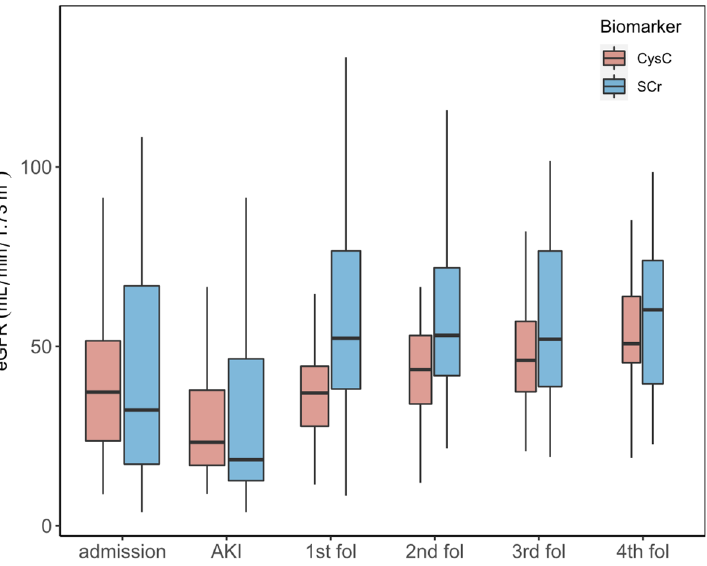
Figure 3. Comparison of estimated glomerular filtration rate using serum creatinine (eGFR SCr ) and estimated glomerular filtration rate using cystatin C(eGFR CysC ) during ICU stay and each follow- up phase.